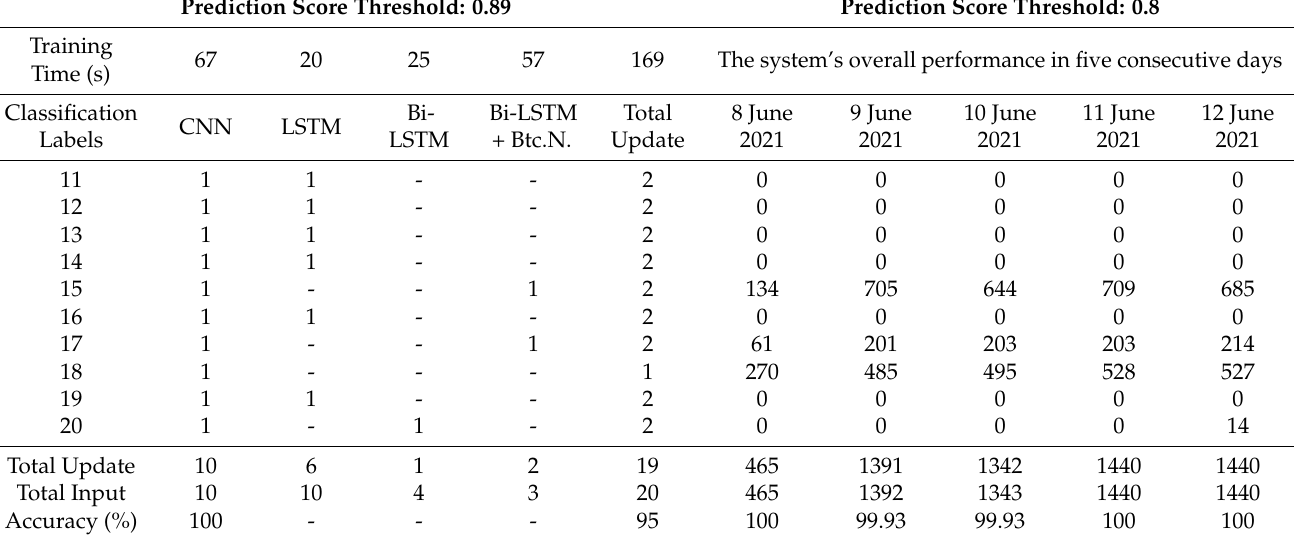
Table 9. Exemplar results of the Real-Time Learning System.